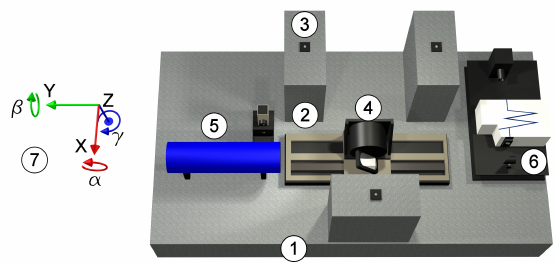
Figure 2: Setup for geometric and spectral measurements. 1 (cid:13) Calibration bench, 2 (cid:13) Pillar carrying sen- sor, 3 (cid:13) Interface plate, 4 (cid:13) Folding mirror, 5 (cid:13) Components for geometric measurements, 6 (cid:13) Components for spectral measurements, 7 (cid:13) Sensor coordinate system.